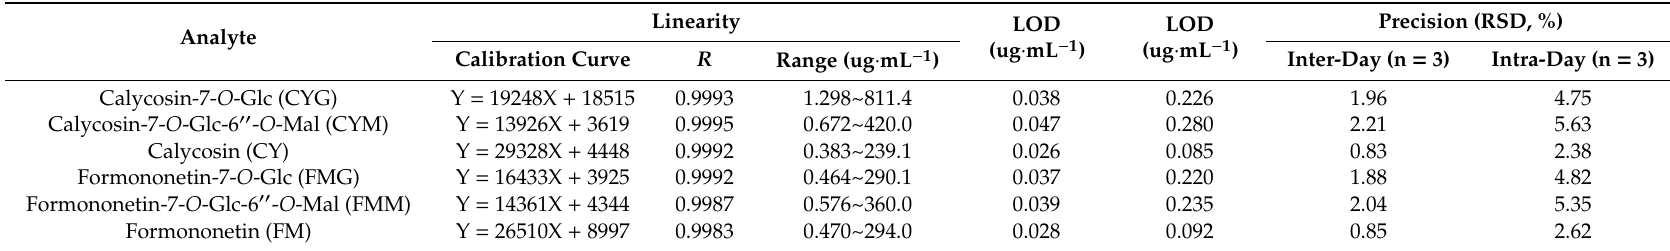
Table 3. Linear relationships, limit of detection (LOD), limit of quantitation (LOQ) and precision of six isoflavoniod references by